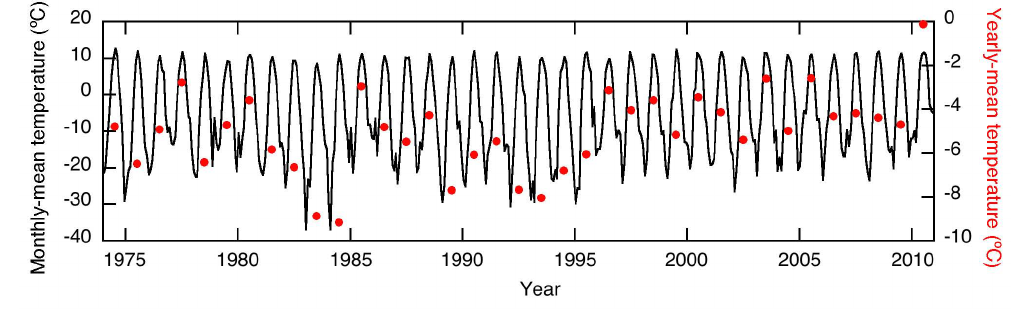
Fig. 2. Monthly-mean (black line) and annual-mean (red dots) temperatures at the Kangerlussuaq settlement.